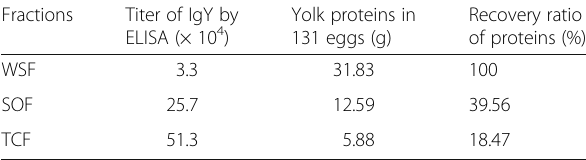
Table 1 Recovery ratio of proteins and titer of IgY fractions Fractions Titer of IgY by ELISA (× 10 4 )